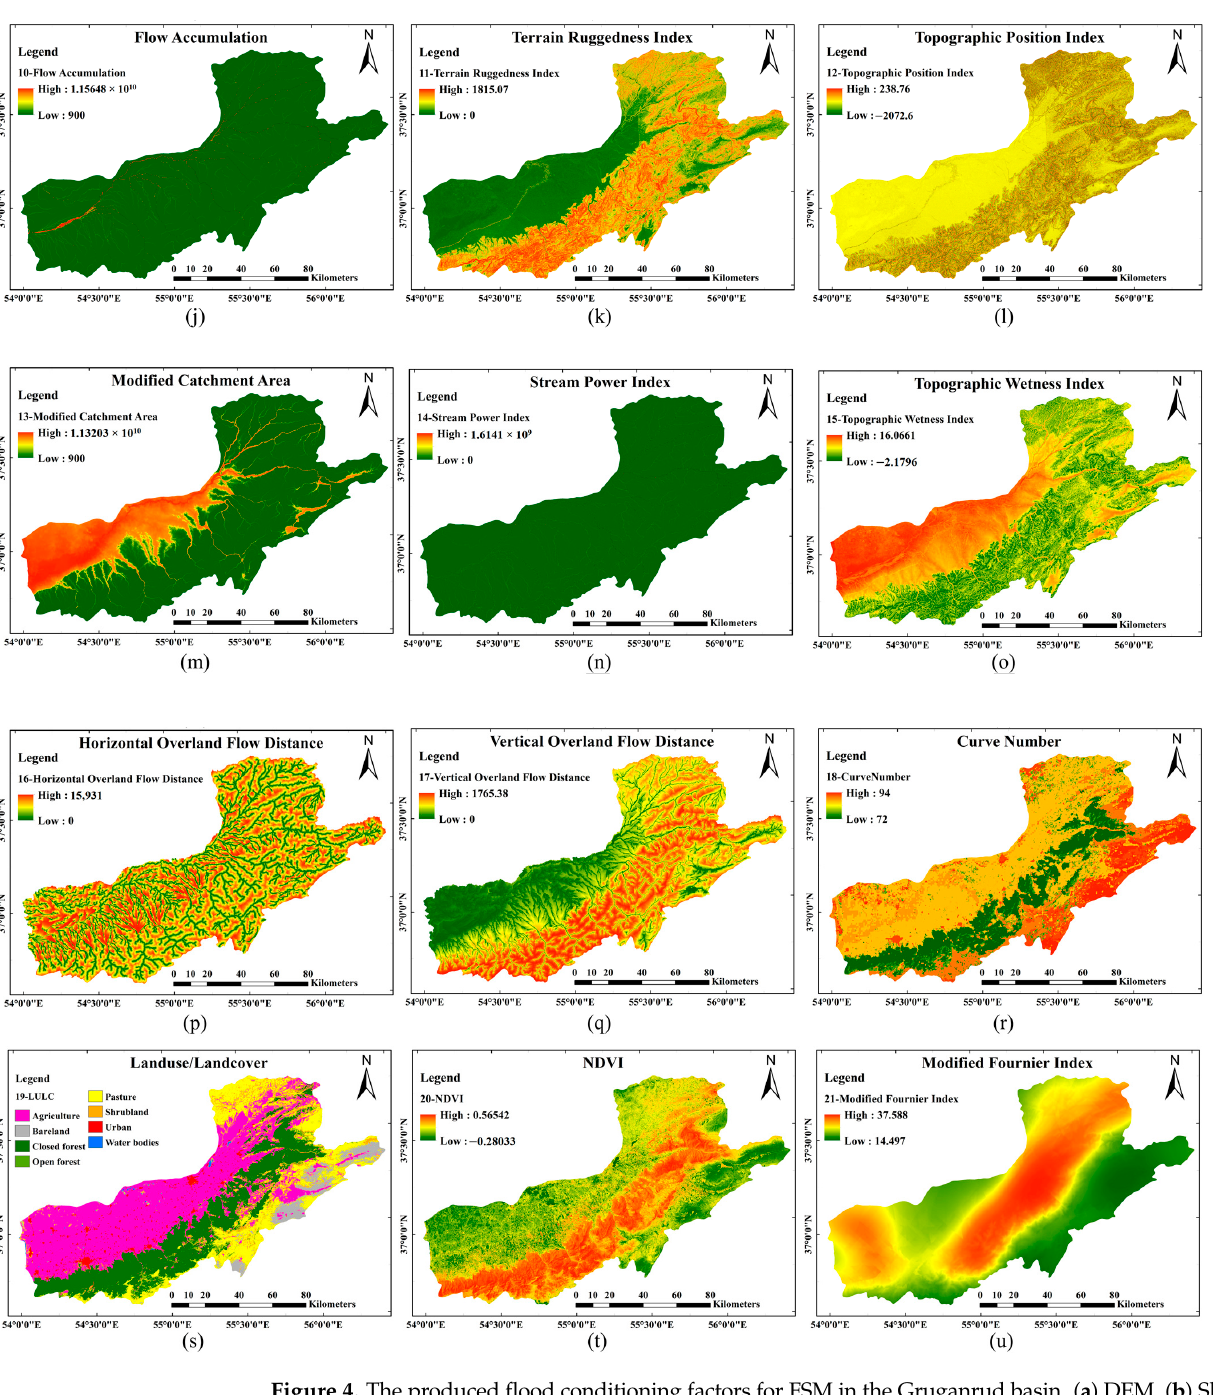
Figure 4. The produced flood conditioning factors for FSM in the Gruganrud basin. ( a ) DEM, ( b ) Slope, ( c ) Aspect, ( d ) Curvature, ( e ) Cross-Sectional Curvature, ( f ) Longitudinal Curvature, ( g ) Convergence Index, ( h ) Valley Depth, ( i ) LS factor, ( j ) Flow Accumulation, ( k ) Terrain Ruggedness, ( l ) Topographic Position Index, ( m ) Modified Catchment Area, ( n ) Stream Power Index, ( o ) Topographic Wetness Index, ( p ) Horizontal Overland Flow Distance, ( q ) Vertical Overland Flow Distance, ( r ) Curve Number, ( s ) Land Use/Land Cover Map, ( t ) Normalized Vegetation Index, and ( u ) Modified Fournier Index.